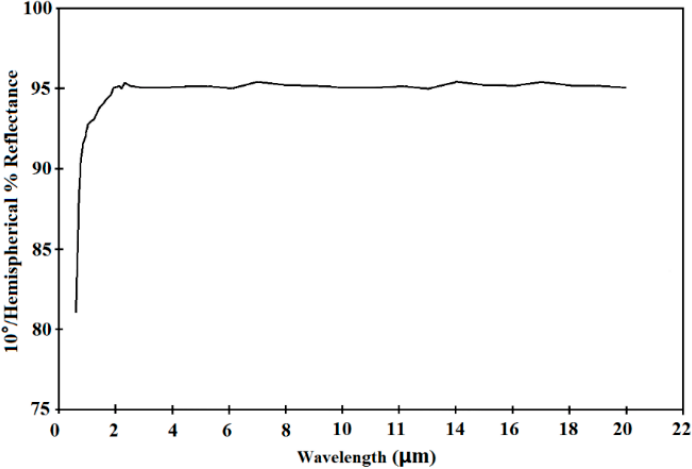
Figure 3. Hemispherical reflectance of the ε InfraGold plate.